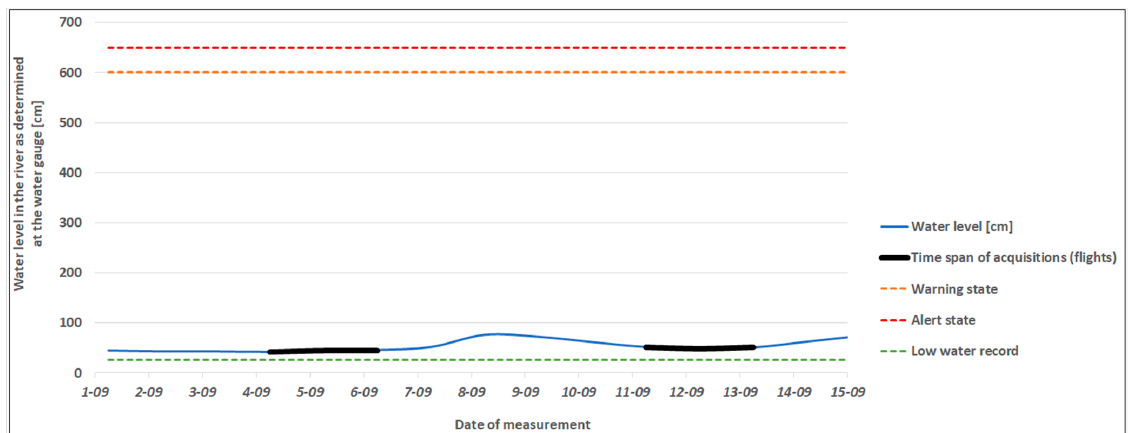
Figure 4. Changes in the water level at the Warsaw “Bulwary” water gauge within the period of UAV and airborne data acquisitions. Hydrological data provided by the Institute of Meteorology and Water Management (IMGW), courtesy of T. Lewicki.